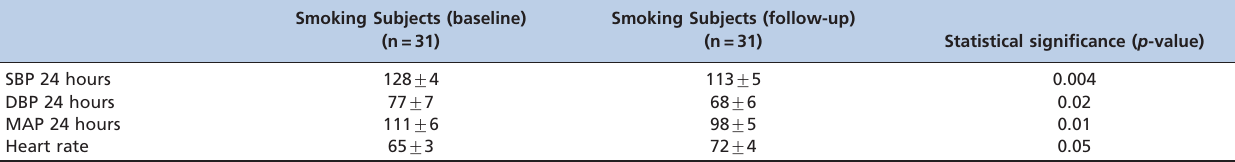
Table 2 - Twenty-four-hour ambulatory blood pressure monitoring data (before and after smoking). Smoking Subjects (baseline) Smoking Subjects (follow-up) (n=31) (n=31)